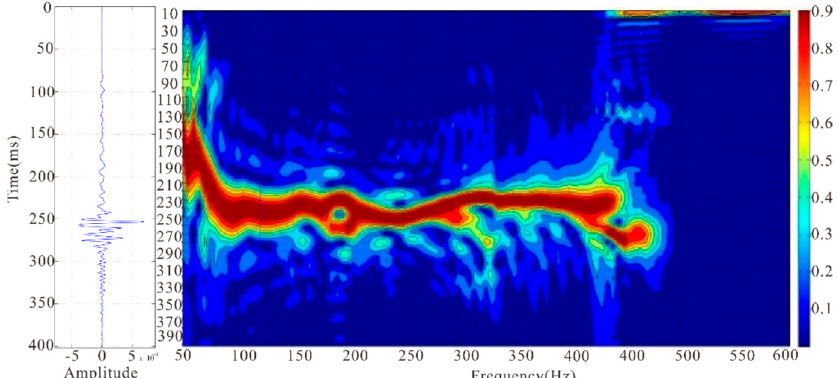
Figure 2. S7-16 seismic trace and dispersion map.